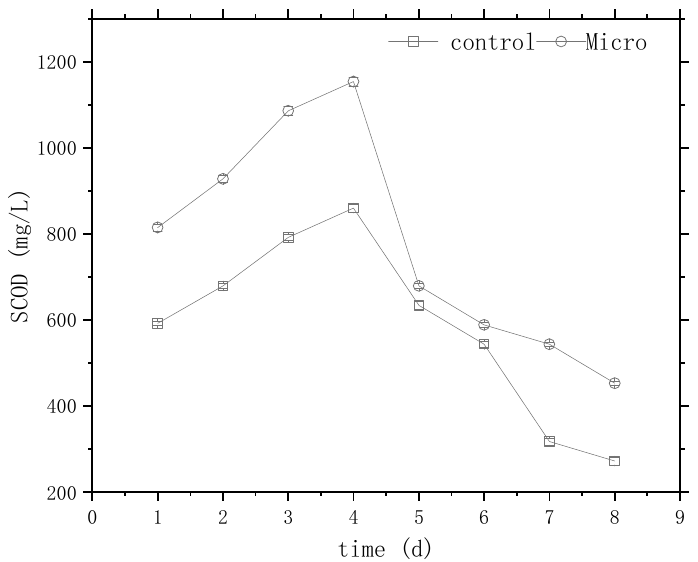
Figure 1. Variation of SCOD concentration under the microaerobic condition.